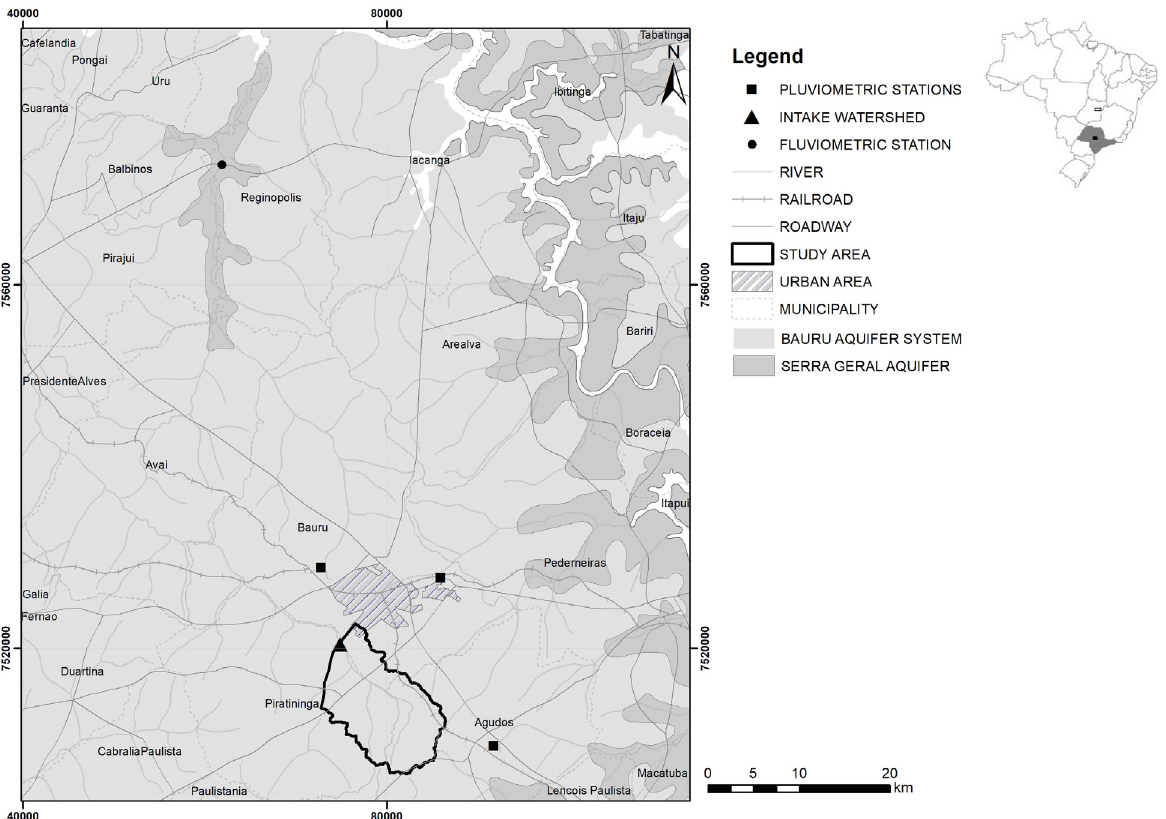
Figure 1. Study area location and the regional hydrogeological